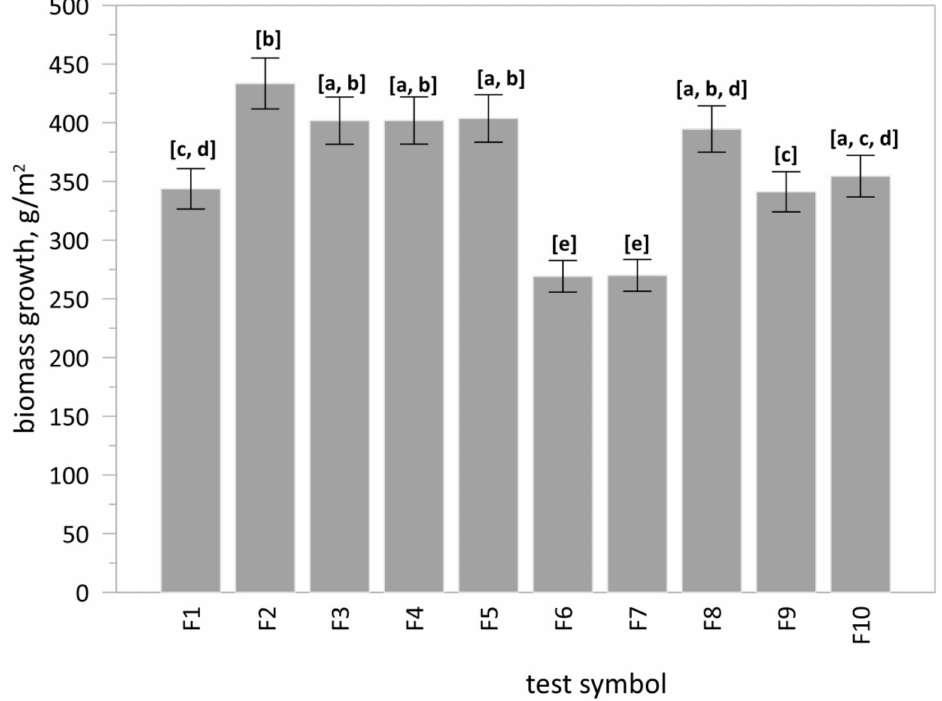
Figure 10. Plant biomass growth in field cultivation. Explanation: bar–mean value, whiskers – standard deviation (n = 3); test symbol according to Table 13; different letters [a, b, c, d, e] indicate significant differences among groups (plots) according to the Tukey’s HSD